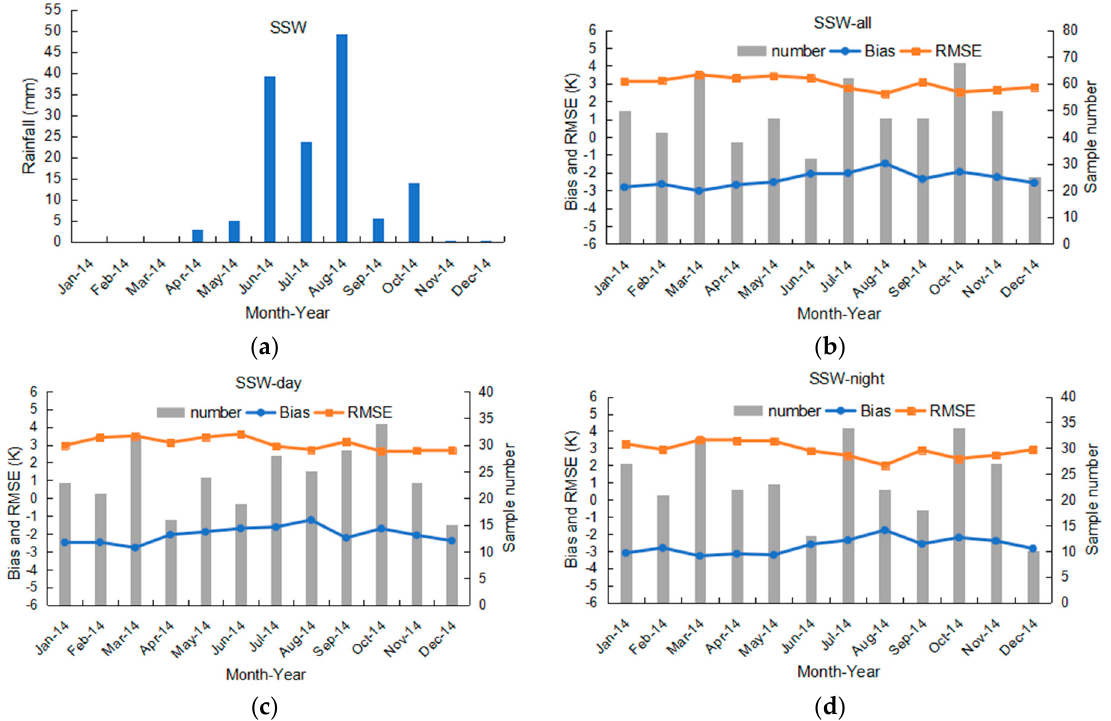
Figure 4. Monthly statistics of rainfall and MODIS LST in 2014 at the SSW site, subplots include ( a ) rainfall, ( b ) all (daytime and nighttime) LSTs, ( c ) daytime LSTs, ( d ) nighttime LSTs.